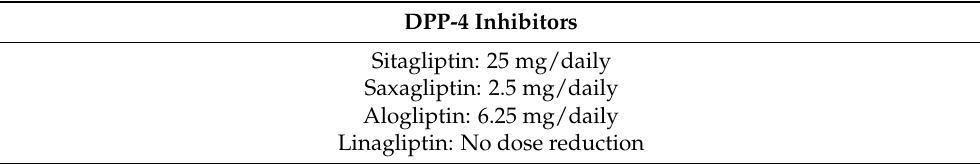
Table 2. Dose adjustment for dipeptidyl peptidase 4 (DPP-4) inhibitors in dialysis patients affected by